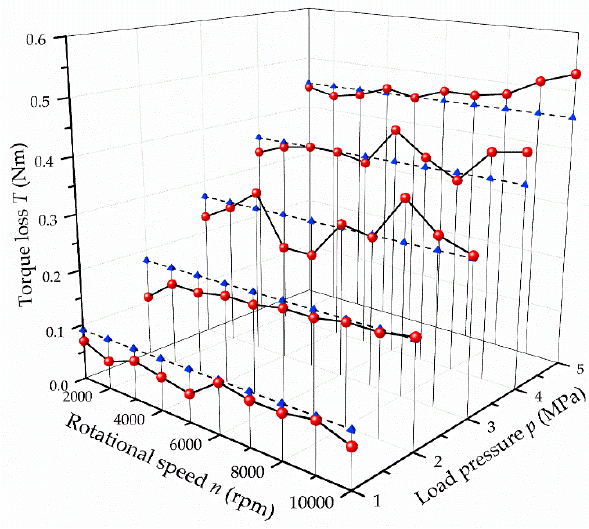
Figure 20. Comparison of practical torque characteristics and theoretical torque characteristics. Table 3. Error between the practical torque loss and theoretical torque loss.